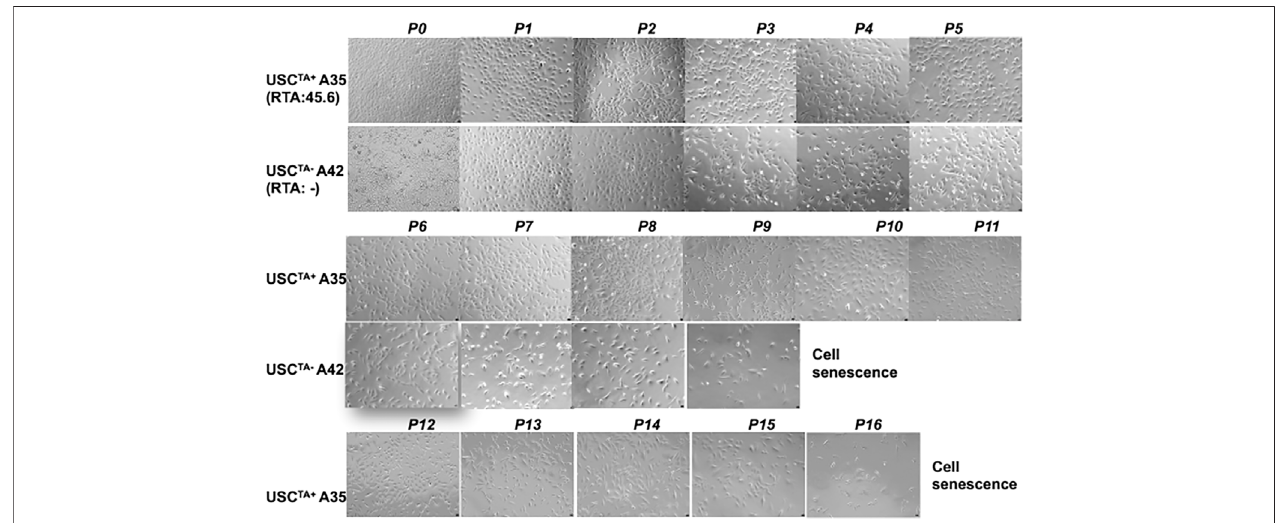
FIGURE3| ChangesinthemorphologicappearanceofUSCs TA+ andUSCs TA − atdifferentpassages. AUSC TA+ clone(A35,RTA:45.6,fromthedonorat20 years ofage)maintainedthe “ rice-grain ” -likeappearanceuptop16;aUSC TA- clone(A42,RTA:negative,fromthesamedonoratanageof20 yearsofage)showeda fl attened cell shape or cells of larger size, and stopped growing (cell senescence) at p9, assessed by phase contrast microscopy. Magni fi cation, ×100.